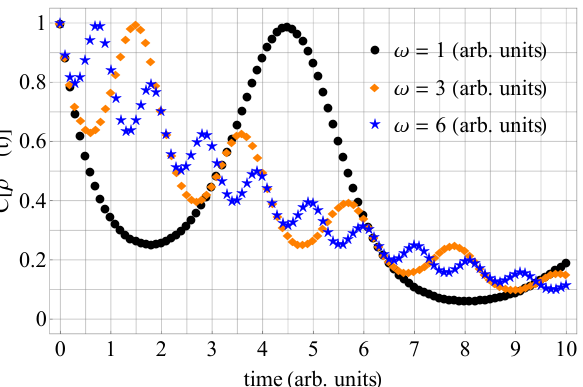
(cid:12) (cid:11)(cid:10) Φ + (cid:12) (cid:12) Φ + (cid:12) .